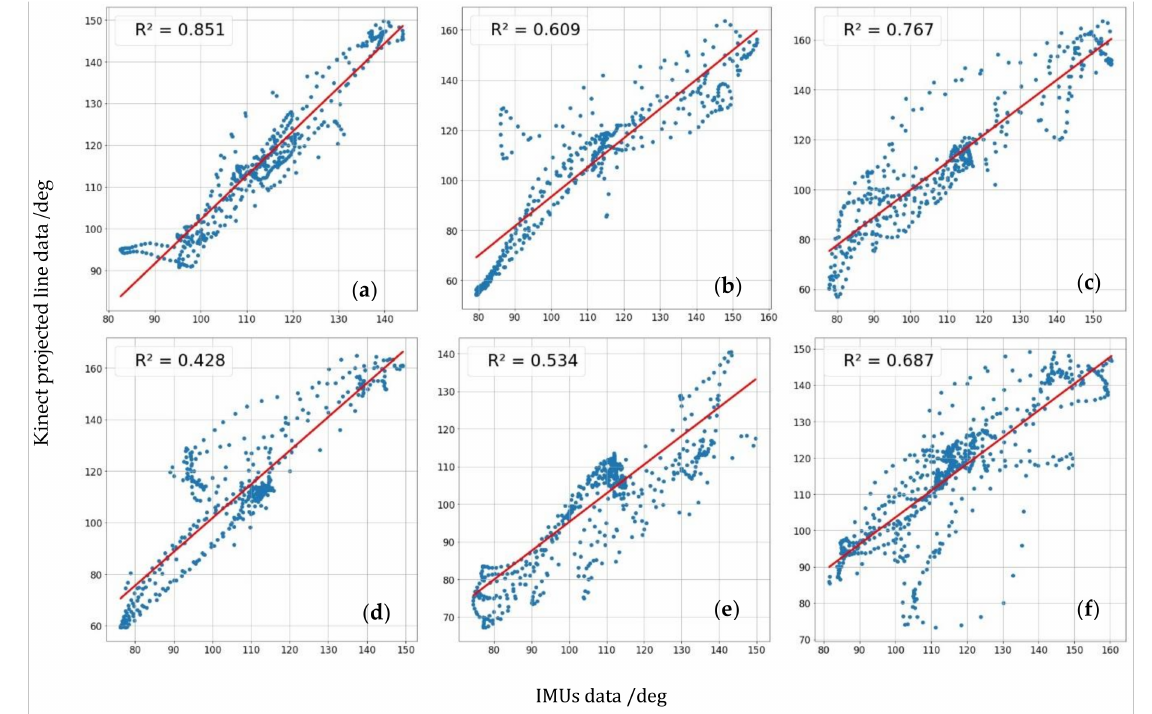
Figure 16. Graph showing the linearity between the ankle angle measured by the Kinect v2 with our method of projection lines and the angle measured by the IMUs using Euler’s angles, for different distances in relation to the Kinect, which are: ( a ) 0.5, ( b ) 1, ( c ) 1.5, ( d ) 2, ( e ) 3 and ( f ) 4 m.